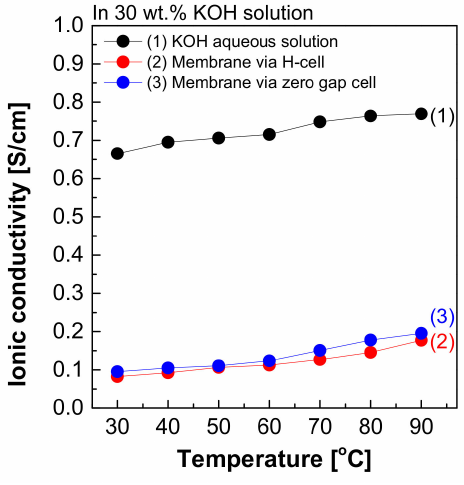
Figure 8. Hydroxide ion conductivity measured using the 2-probe method in 30 wt.% KOH